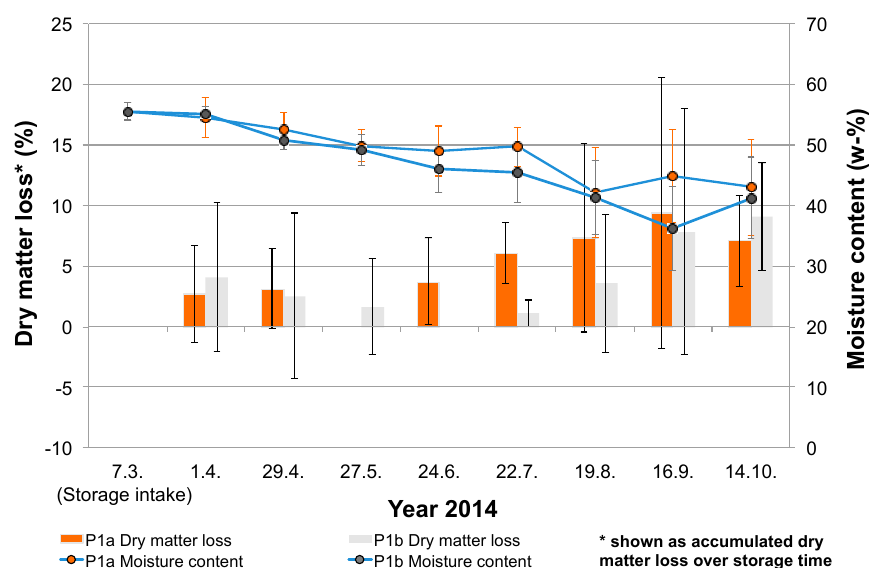
Figure 8. Dry matter losses and moisture contents during storage trial P1 in Potsdam (P1a = without branches, P1b = with branches).